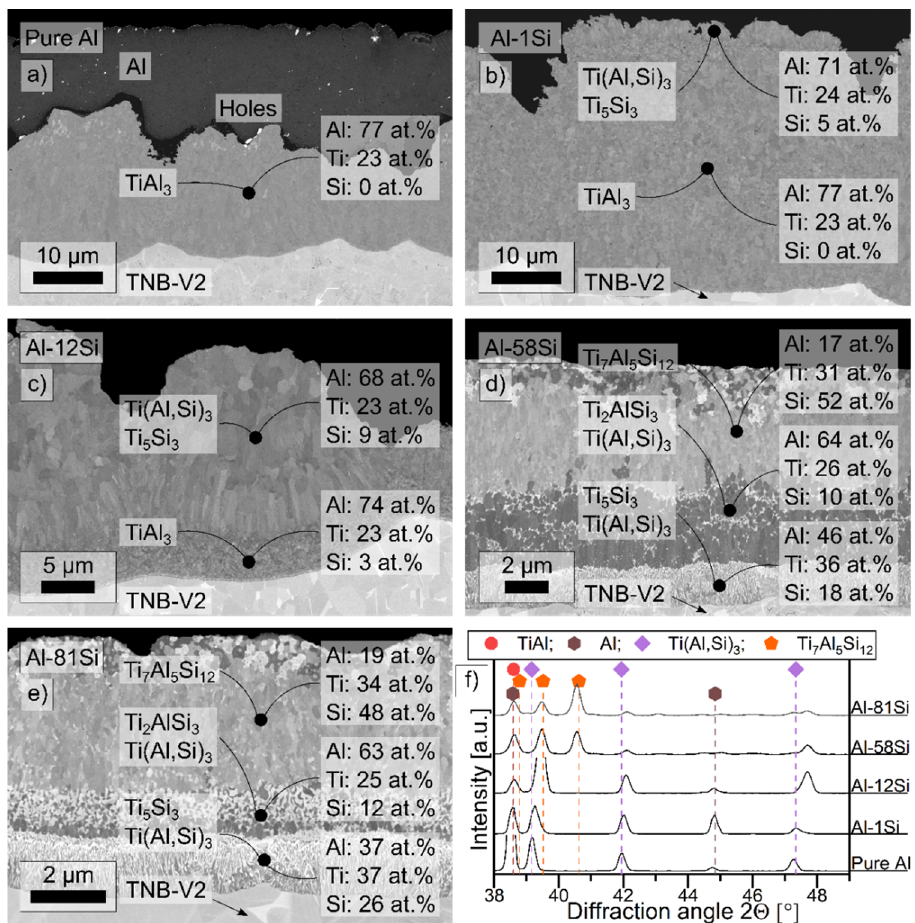
Figure 3. Cross sectional SEM images of the magnetron sputtered coatings on a TNB-V2 alloy: ( a ) the pure Al coating, ( b ) the Al-1Si, ( c ) the Al-12Si, ( d ) the Al-58Si and ( e ) the Al-81Si coating (all in at.%) after a vacuum heat treatment at 600 °C for 20 h, as well as the corresponding diffractograms ( f ). The chemical compositions were measured by EDS.